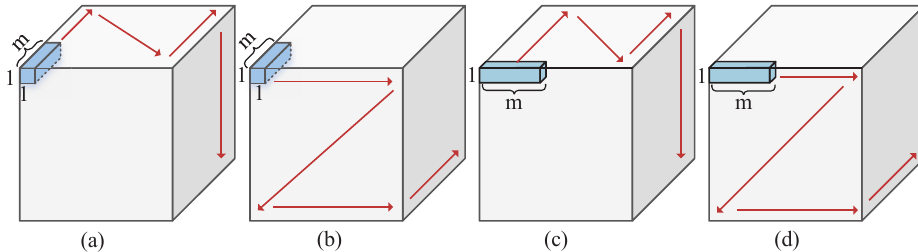
Figure 5. Four convolution orders based on the minimum cache and access unit. ( a ) The convolution order with pointwise unit and pointwise loop (PUPL). ( b ) The convolution order with pointwise unit and depthwise loop (PUDL). ( c ) The convolution order with depthwise unit and pointwise loop (DUPL). ( d ) The convolution order with depthwise unit and depthwise loop (DUDL).